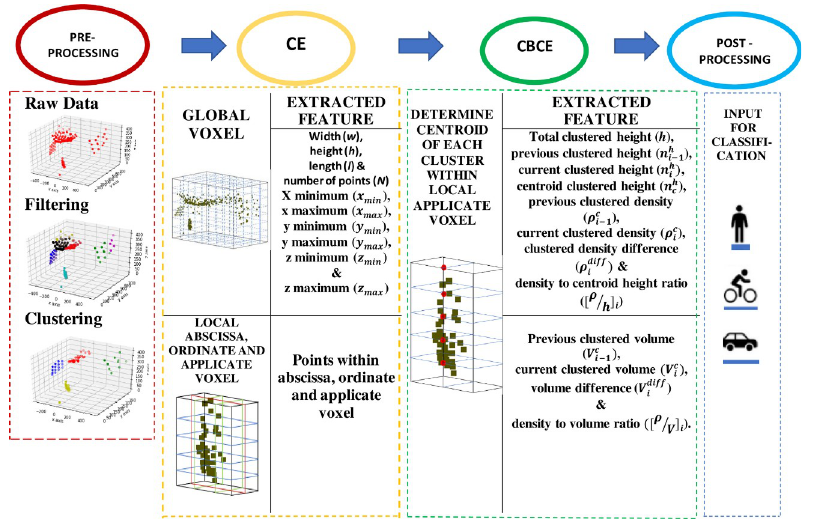
Fig 4. Flowchart of the proposed feature extraction method through CE-CBCE.